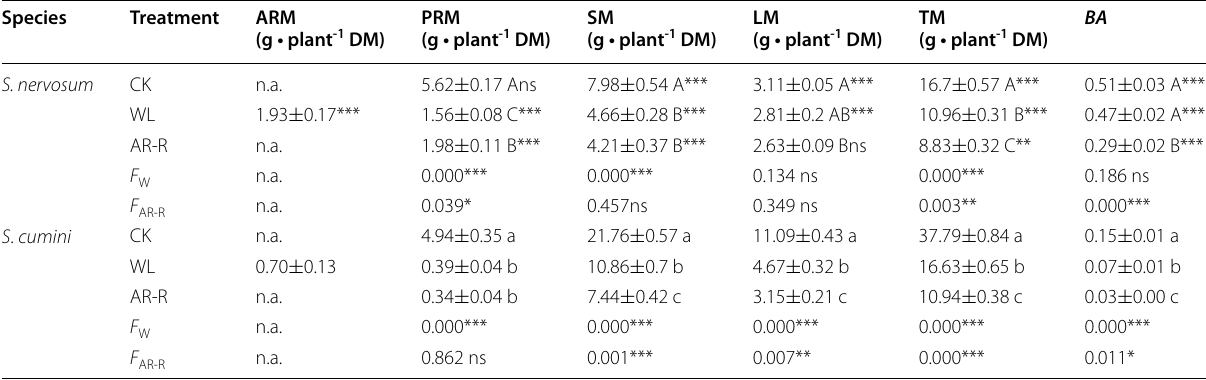
Table 1 Biomass accumulation and allocation in S . nervosum and S . cumini saplings, as affected by waterlogging with or without adventitious root